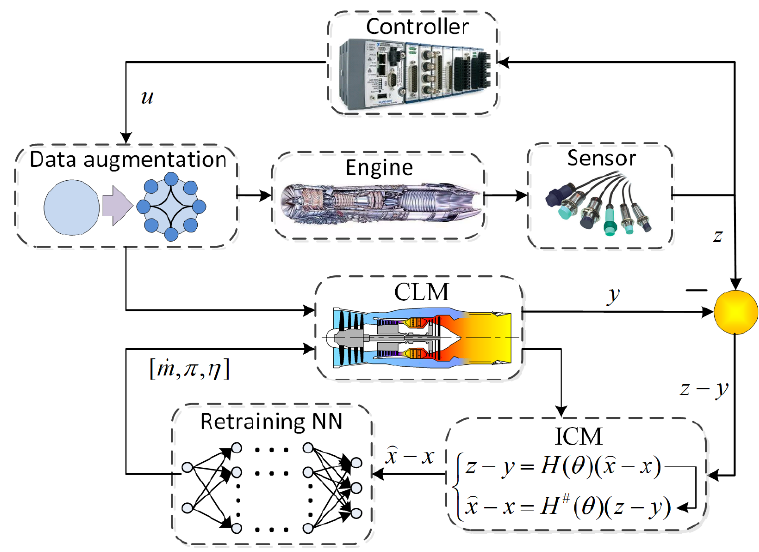
Figure 3. The illustration of the steady state adaptation strategy.